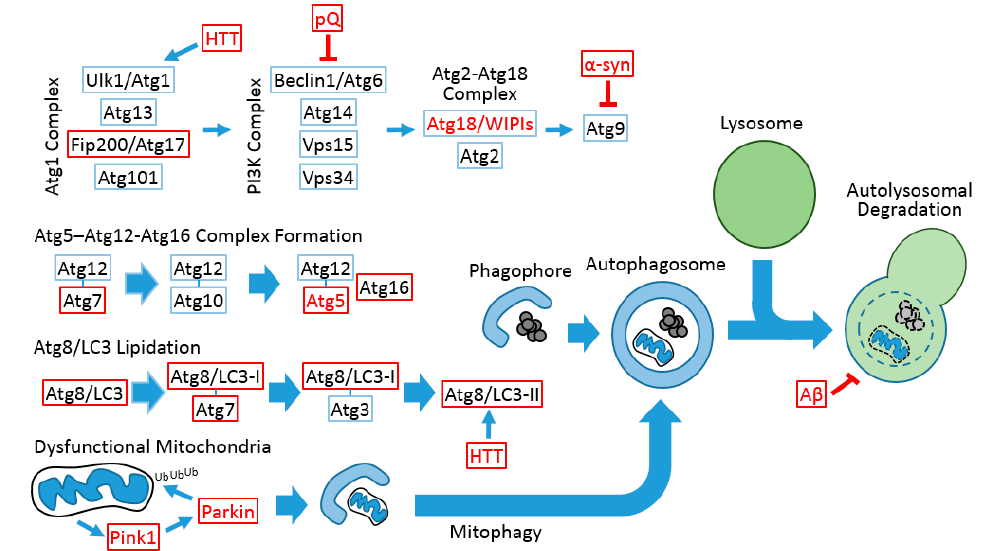
Figure 1. Conserved autophagic processes between Drosophila and mammals. Red letters indicate that the gene and protein are associated with neurodegenerative diseases in humans. Red boxes indicate that the gene mutation and/or transgenic modulation can provoke neurodegeneration or neuronal dysfunction in the Drosophila system. Blue boxes indicate that, although the Drosophila gene is implicated in the autophagic process, its function in neuronal homeostasis has not been assessed. Thin arrows indicate signal flow, and thick arrows indicate the modification of complexes and vesicles. Blunted arrows indicate inhibition signals. The autophagosomal inner membrane and its contents are degraded after lysosomal fusion (dashed circle). pQ, polyglutamine tract; α -syn, α -synuclein; HTT, Huntingtin; A β , β -amyloid.